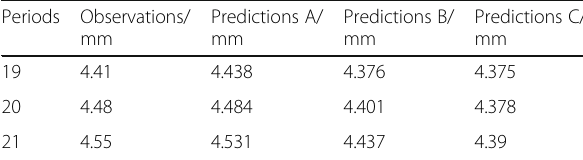
Table 3 Forecast results of the combined model Periods Observations/ mm